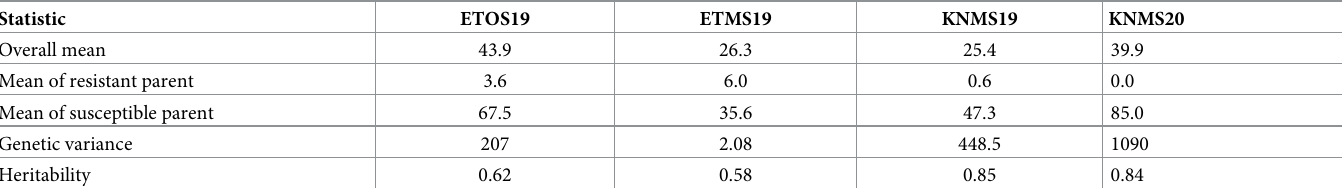
Table 2. Mean, genetic variance and broad-sense heritability of CI of RIL population across four testing environments.